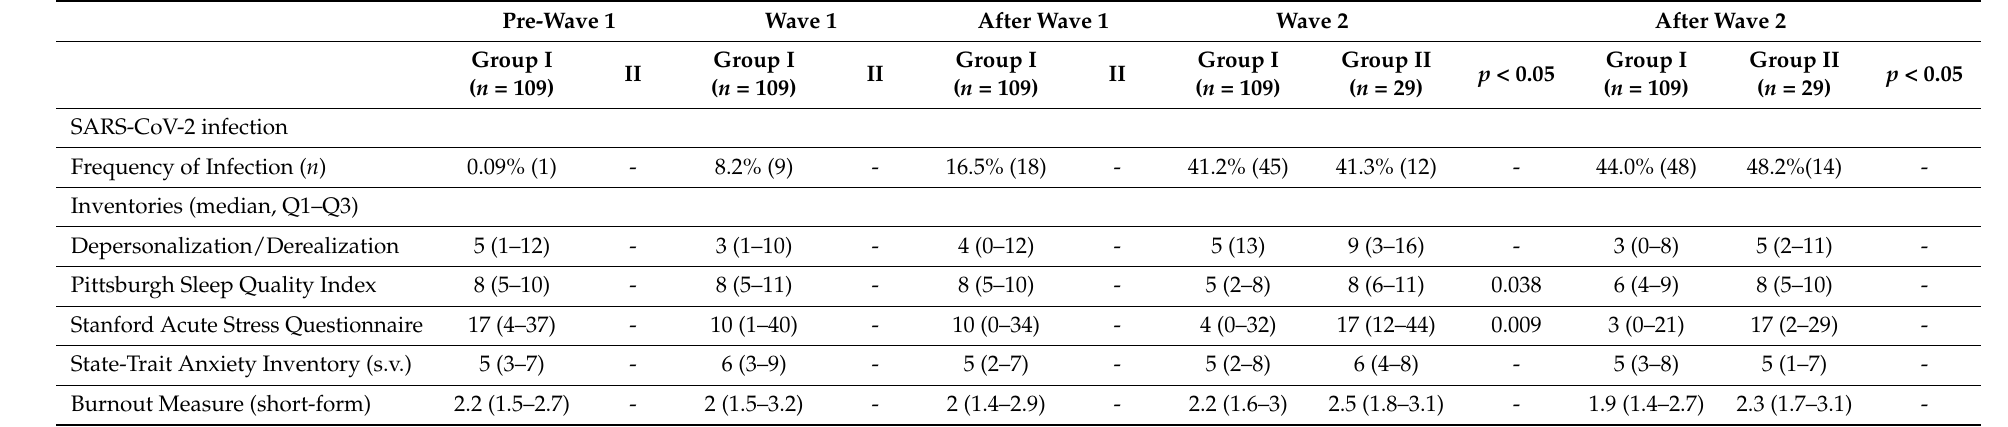
Table 2. Frequency of infection by SARS-CoV-2, and median with quartiles 1 and 3 (Q1–Q3) of the inventory scores, during the follow-up of 138 frontline health workers, in the course of the first and second epidemic waves, according to the time point at inclusion in the study. Comparisons were performed using the “ t ” test for proportions and the Mann–Whitney “ U ” test.